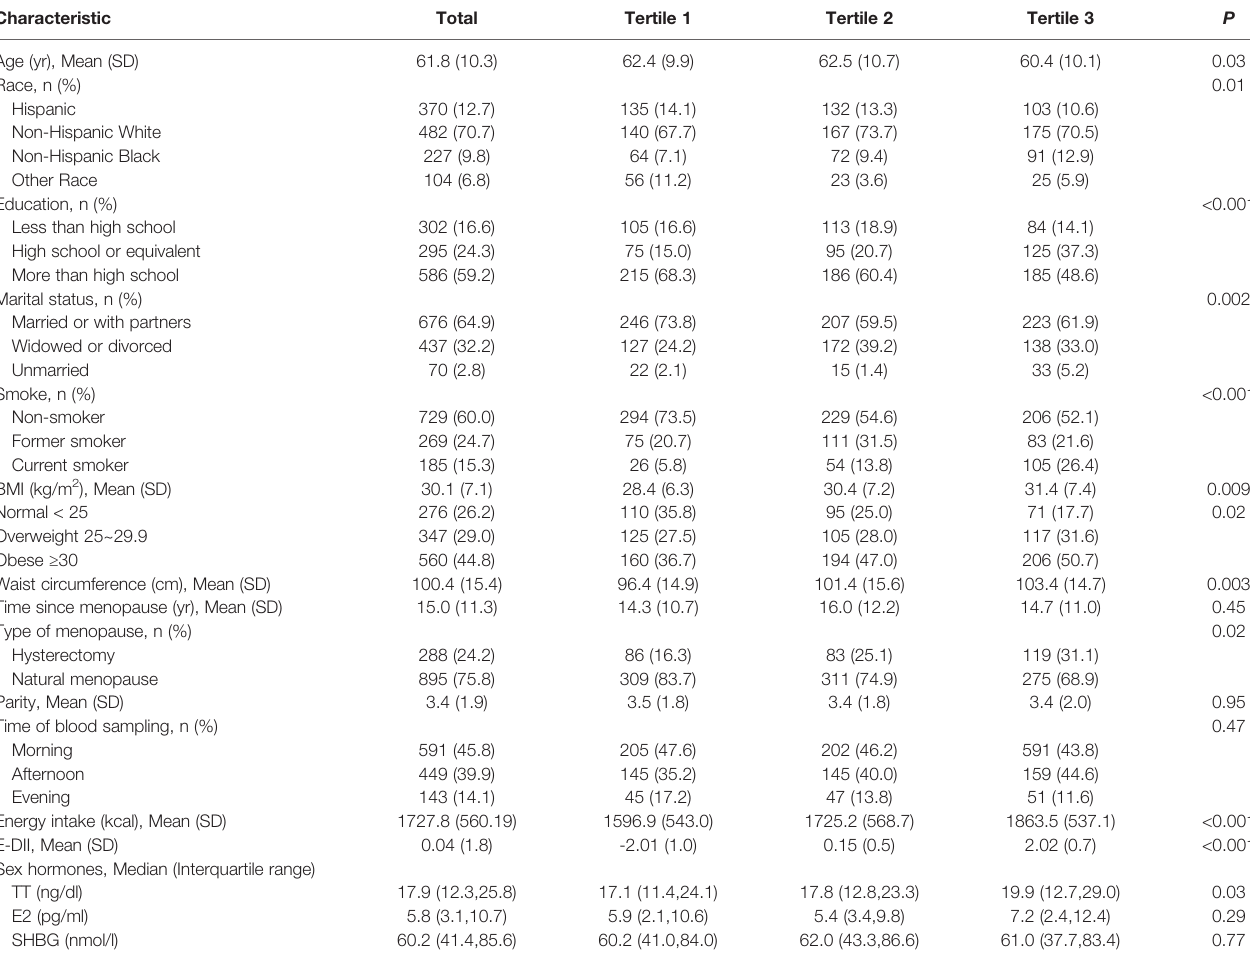
All the above mean, standard deviation, and percentage offrequency were weighted except for the frequency. E-DII, energy-adjusted dietary in fl ammation index; BMI, body mass index; TT, total testosterone; E2, estradiol; SHBG, sex hormone-binding